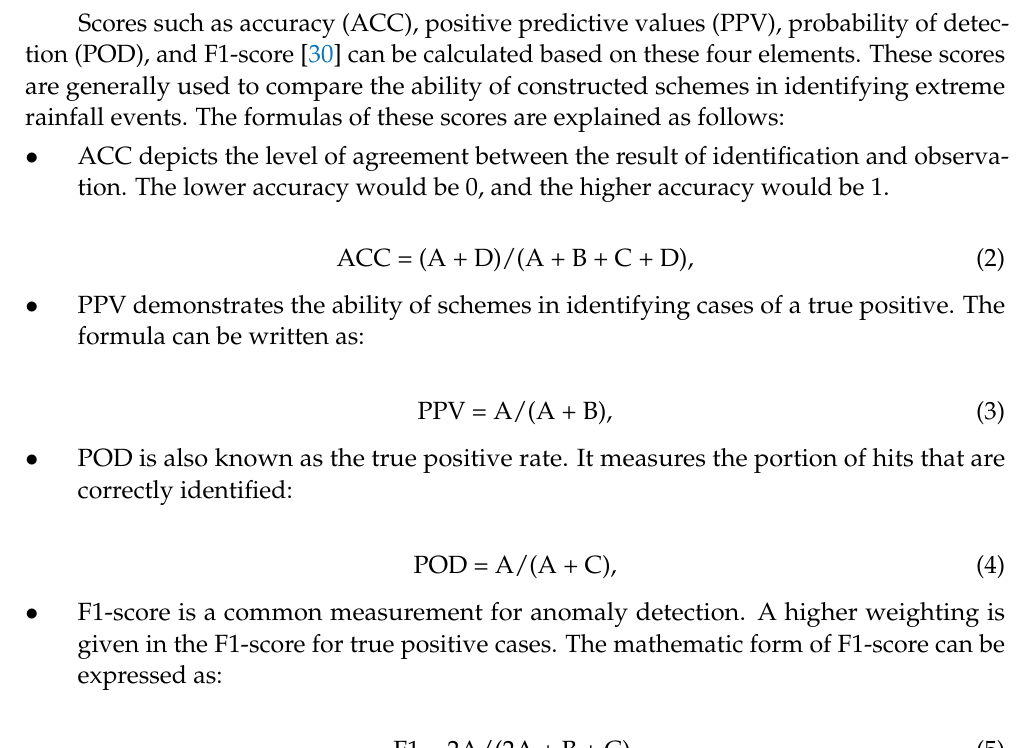
Observation True